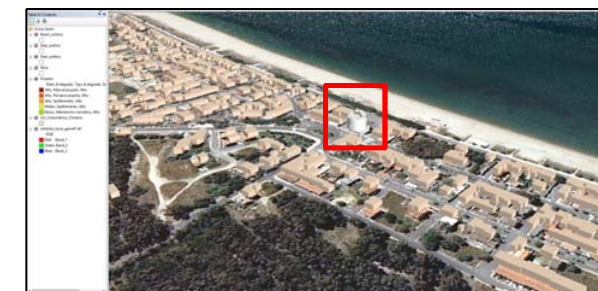
Figure 7. Selection of the windows in the residence of the lighthouse keeper in Arcscene